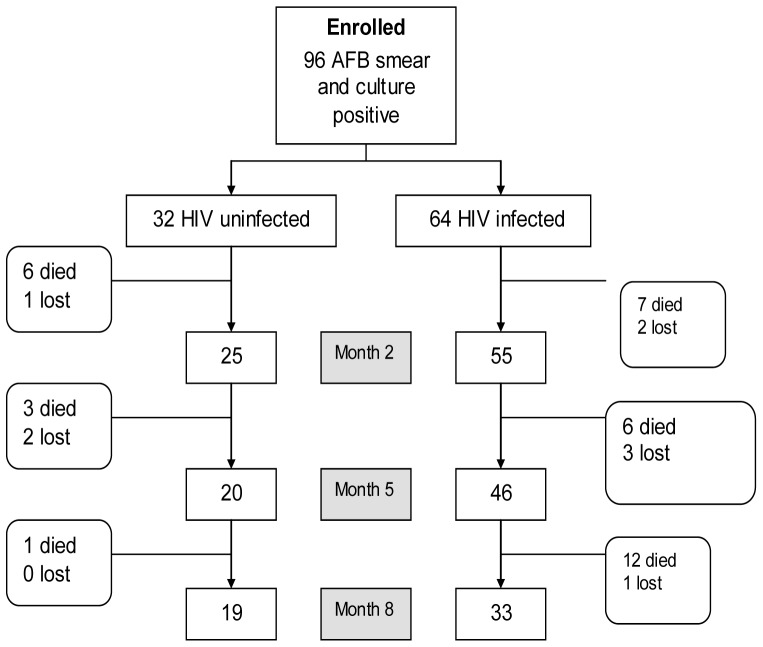
Study profile during the 8-month TB treatment period.Note: Of the 19 HIV uninfected who were still in the study at month 8, 17 were classified as cured/completed, 1 failed treatment and was put on a retreatment regimen and 1 had an unknown outcome. Of the 33 HIV infected who were still in the study at month 8, 22 were classified as cured or completed treatment, 7 failed treatment (of whom 5 were put on retreatment) and 4 had unknown outcomes.